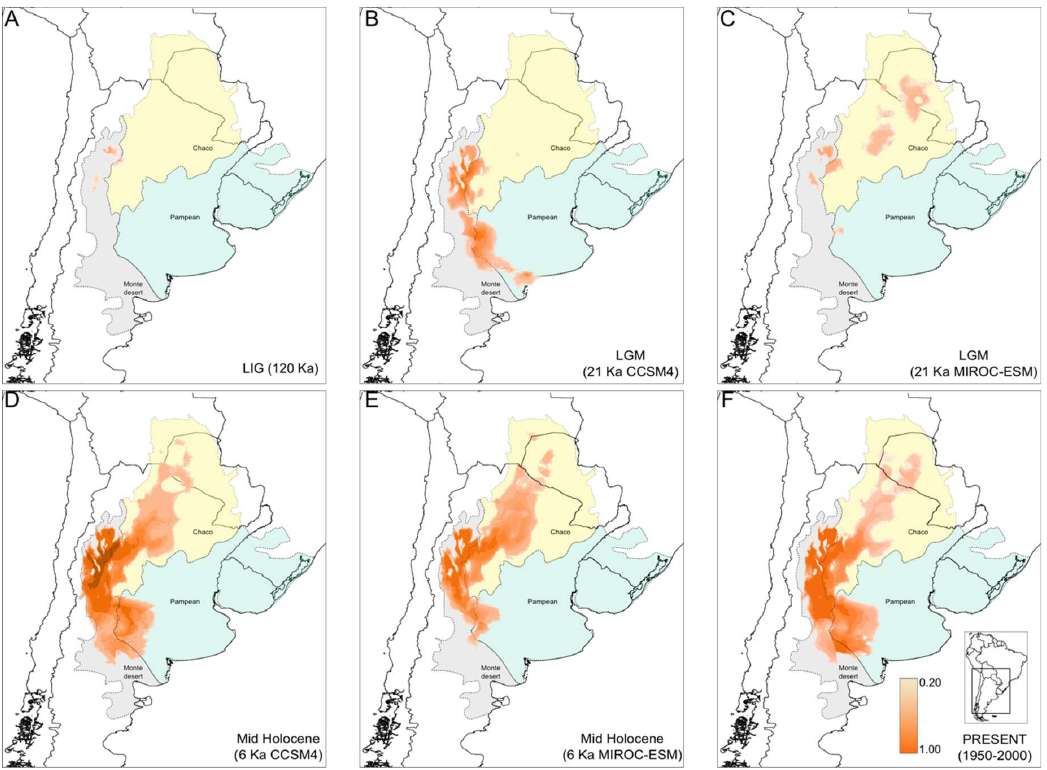
Figure 7. Spatial projections of Prosopanche americana climatic niche across several Quaternary climatic scenarios . ( A ) Last Interglacial maximum (LIG; 120 kya; CCMS); ( B ) Last Glacial Maximum (LGM; 21 kya; CCMS4); ( C ) Last Glacial Maximum (LGM; 21 kya; MIROC-ESM); ( D ) Mid-Holocene (6 kya, CCMS4); ( E ) Mid-Holocene (6 kya, MIROC-ESM); ( F ) Current conditions (average 1950–2000). Dotted lines indicate biogeographical regionalization and orange hues signals the climatic suitability for P. americana.